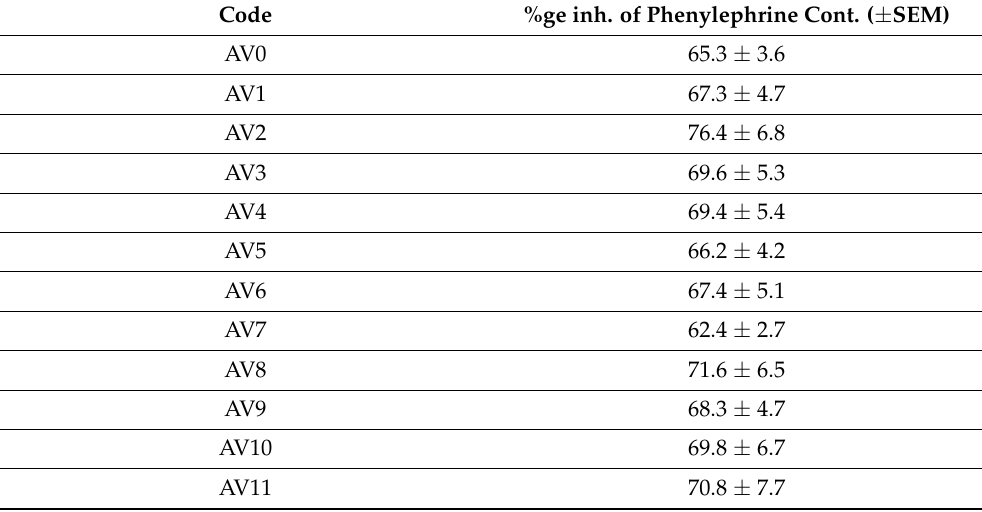
Table 3. Results of inhibitory effects of synthesized derivatives of 2-(N-((2 (cid:48) -(2H-tetrazole-5-yl)-[1,1 (cid:48)